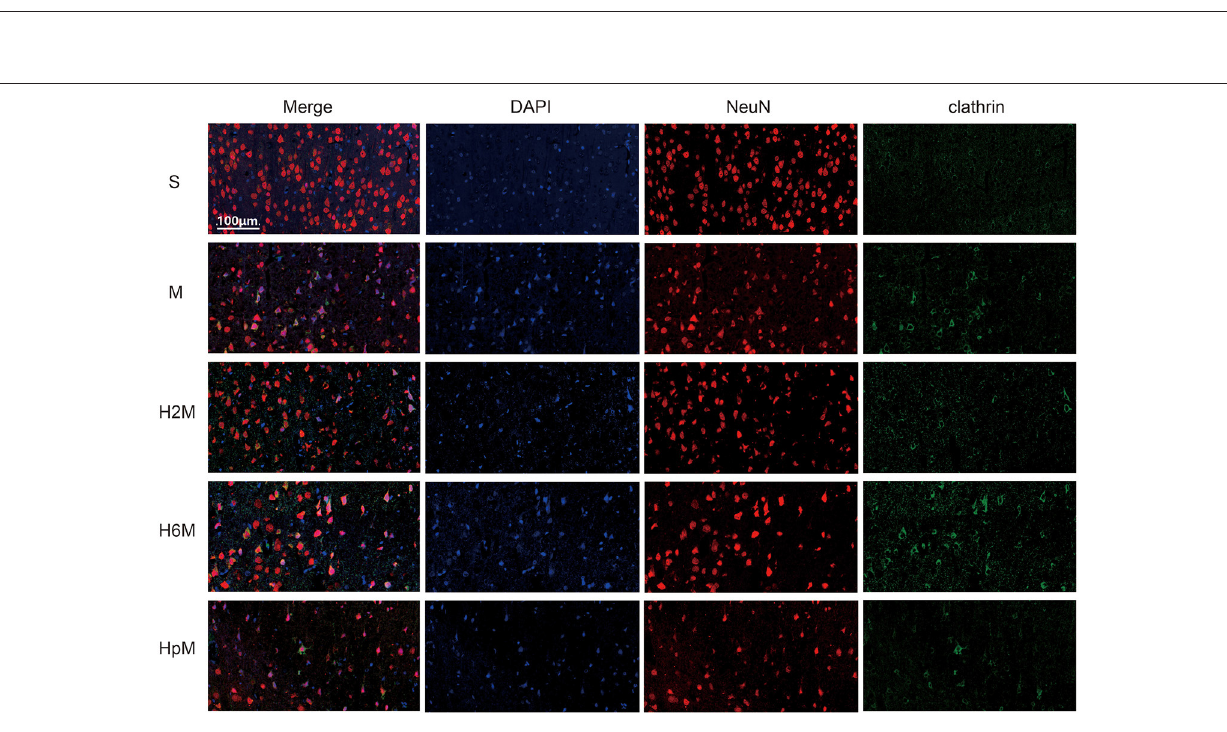
Frontiers in Neurology |